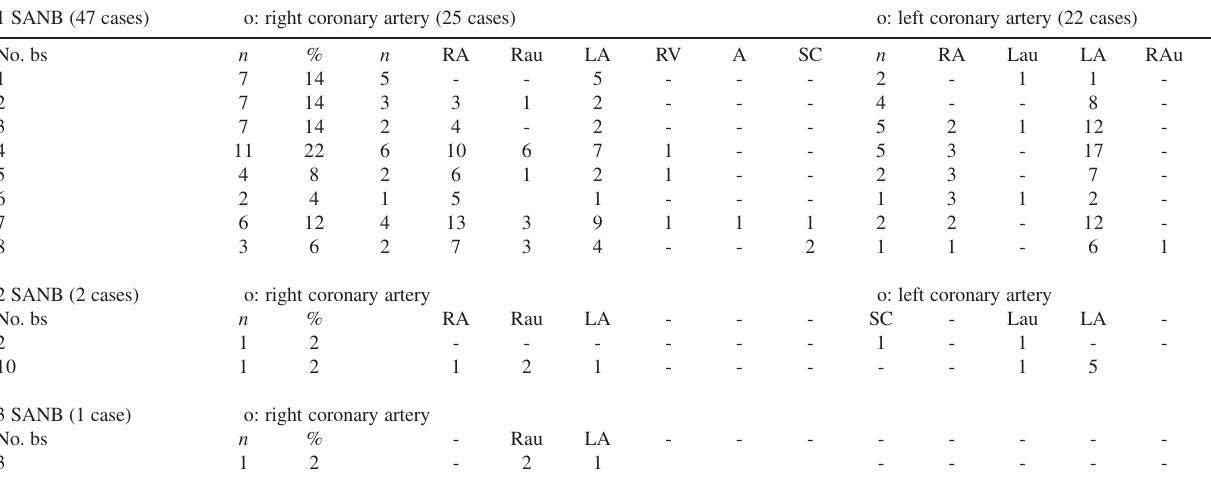
Table 2 - Distribution of number, diameter, and territory of irrigation of the collateral branches of the sinuatrial nodal artery